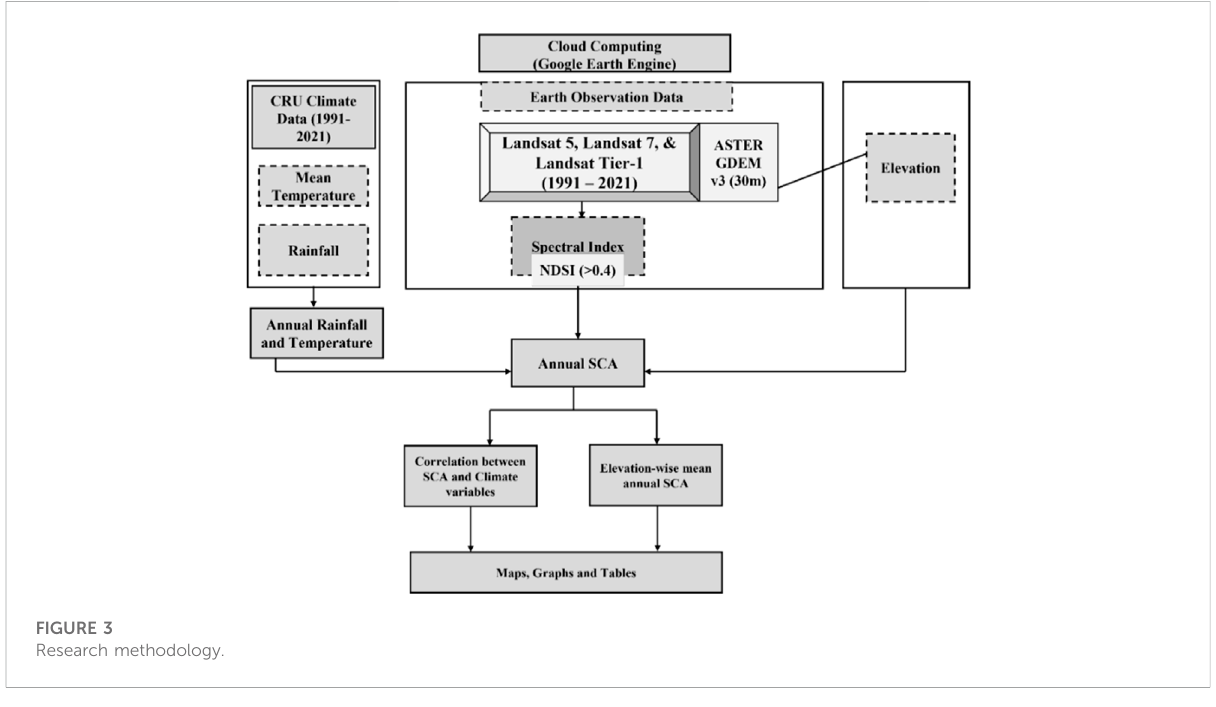
FIGURE 3 Research methodology.